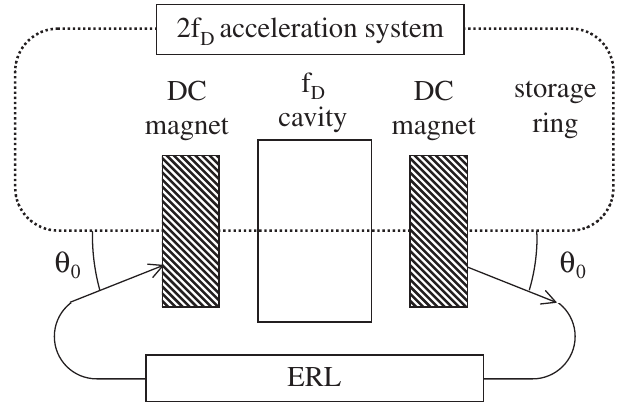
FIG. 2. Possible configuration of two-turn system. Two DC magnets are placed one on either side of deflection cavity ). Acceleration system (frequency of 2 f (frequency of f D ring compensates radiation loss of beam.